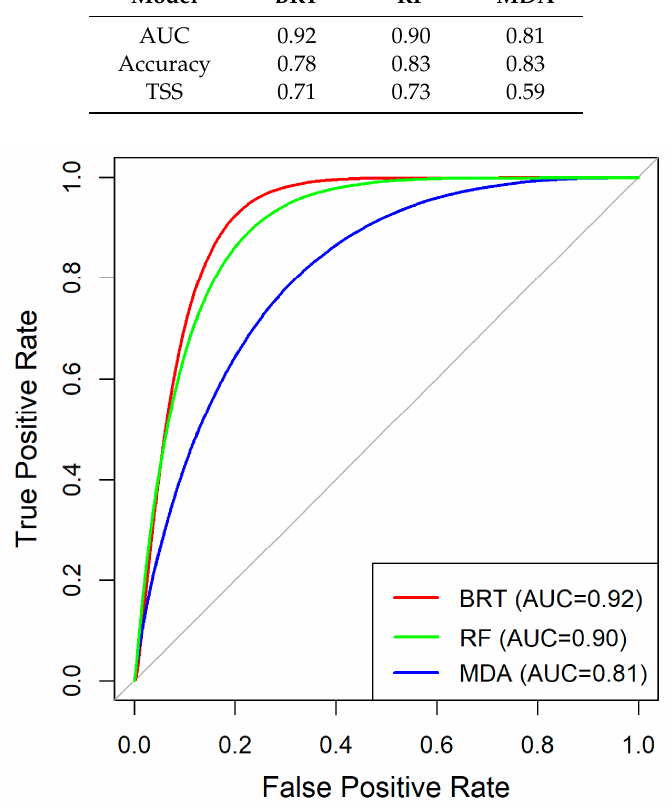
Figure 3. The area under curve (AUC) values for the models.